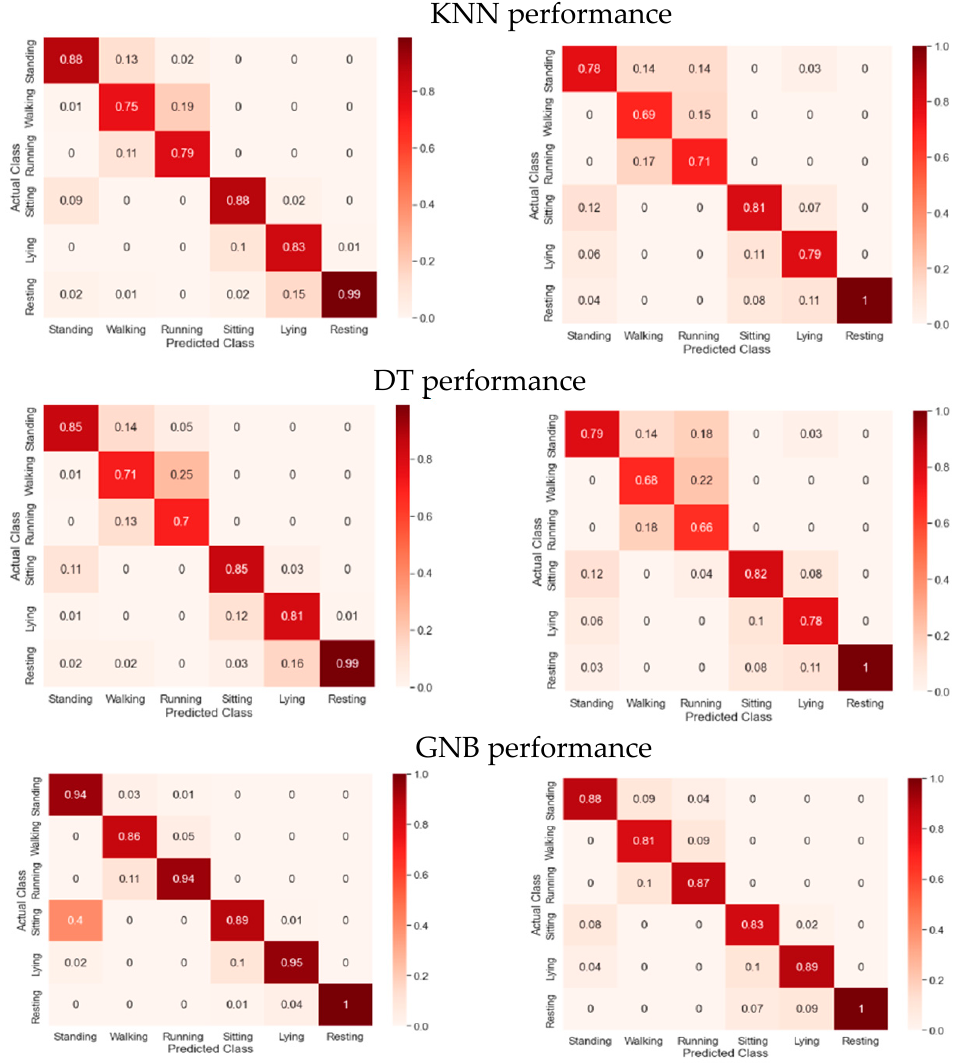
Figure 4. Confusion matrixes of classifiers performances. The left-side pictures represented the performance of a particular classifier when it used the quaternion values as the primary data source. The right-side pictures represented the performance of a particular classifier when it used the sensor data as the primary data source.